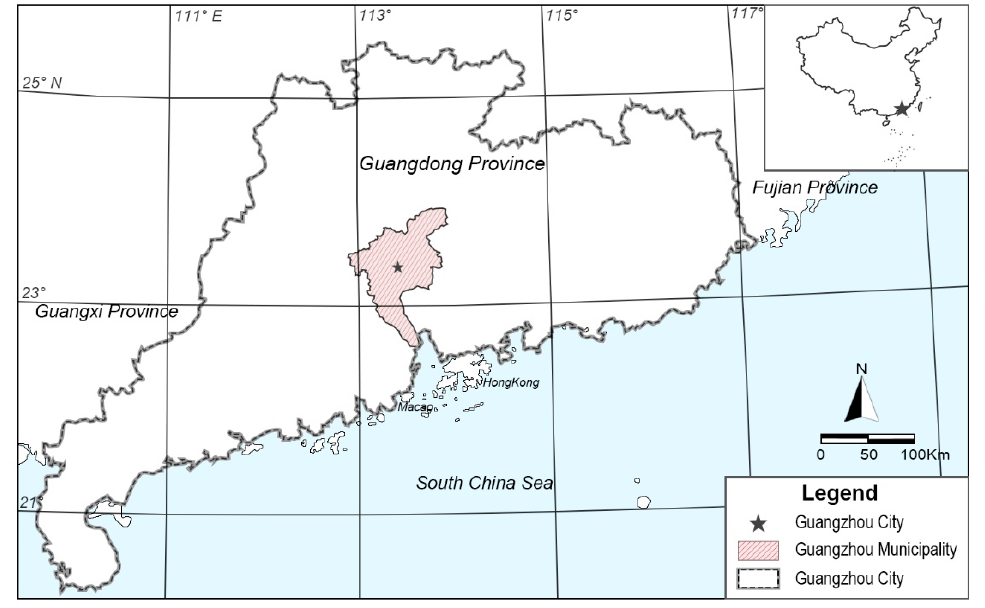
Figure 1. Location of Guangzhou.